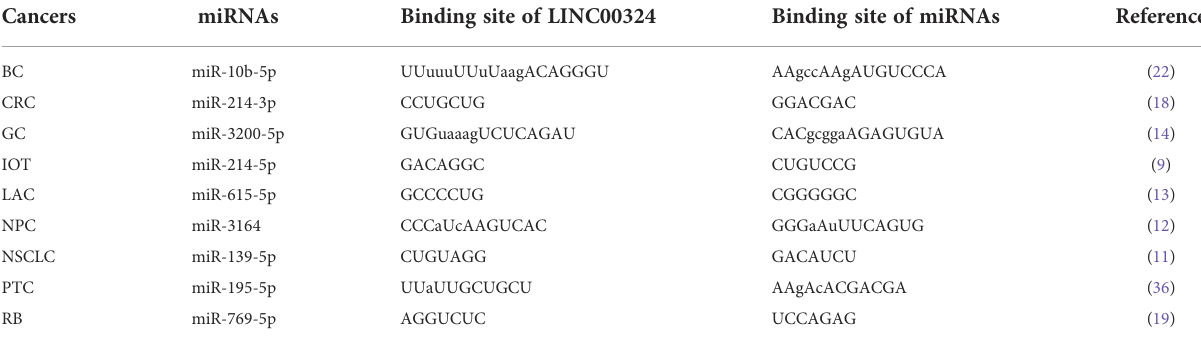
TABLE 2 MiRNAs regulated by LINC00324 and corresponding binding sites.